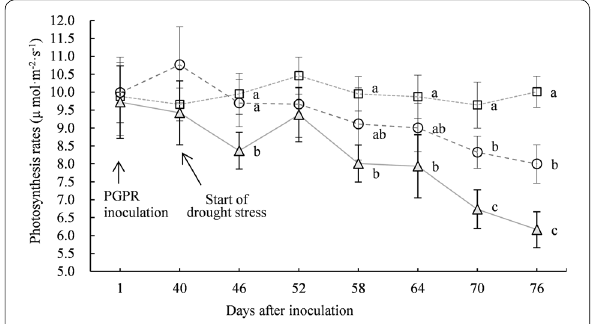
Fig. 1 Effects of Acinetobacter calcoaceticus X128 inoculation on the photosynthetic rates of Sambucus williamsii Hance container seedlings under drought-stressed condition. Values are means of three repeating groups (twelve seedlings for each repeat group). Bars represent the standard deviation. Different letters indicate significant differences for the photosynthetic rates on the same day after inoculation at P < 0.05 by